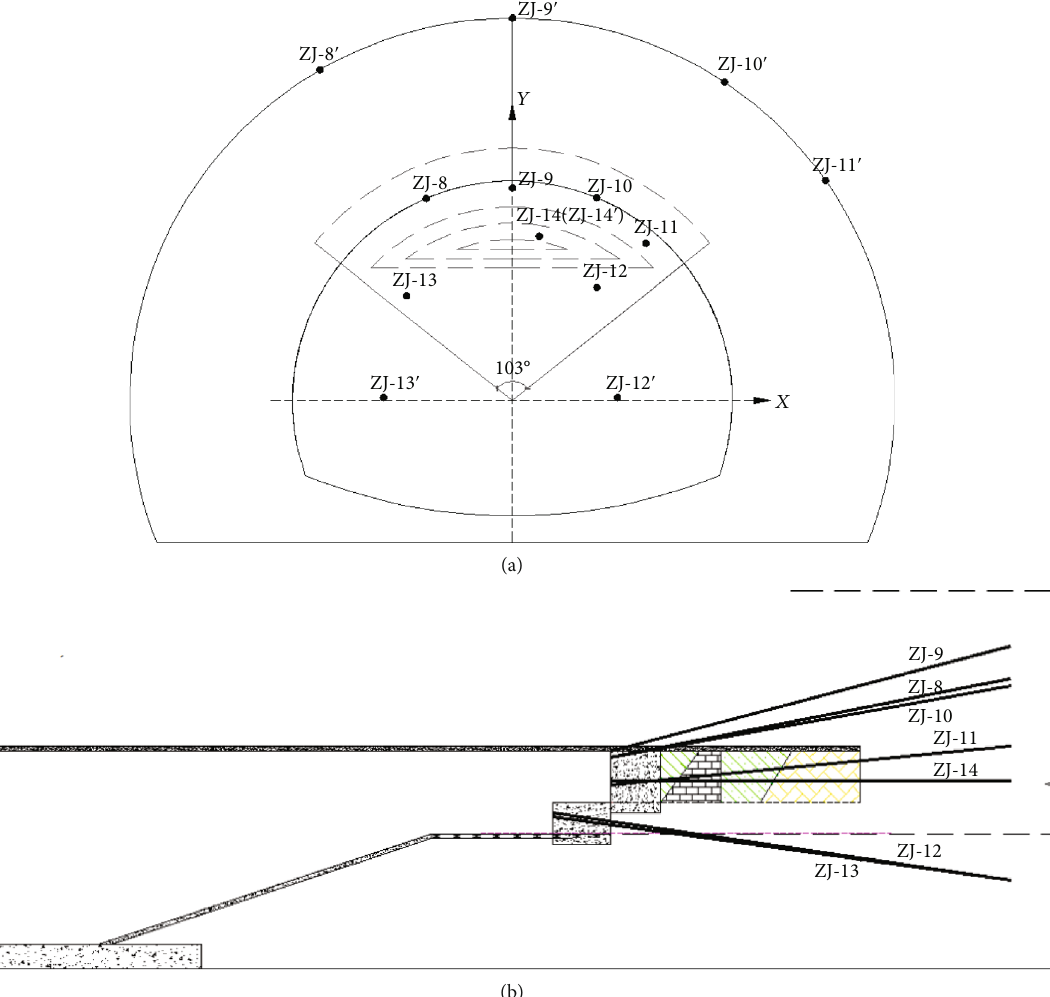
Figure 17: Layout of detection hole after supplementary grouting: (a) cross section and (b) longitudinal pro fi